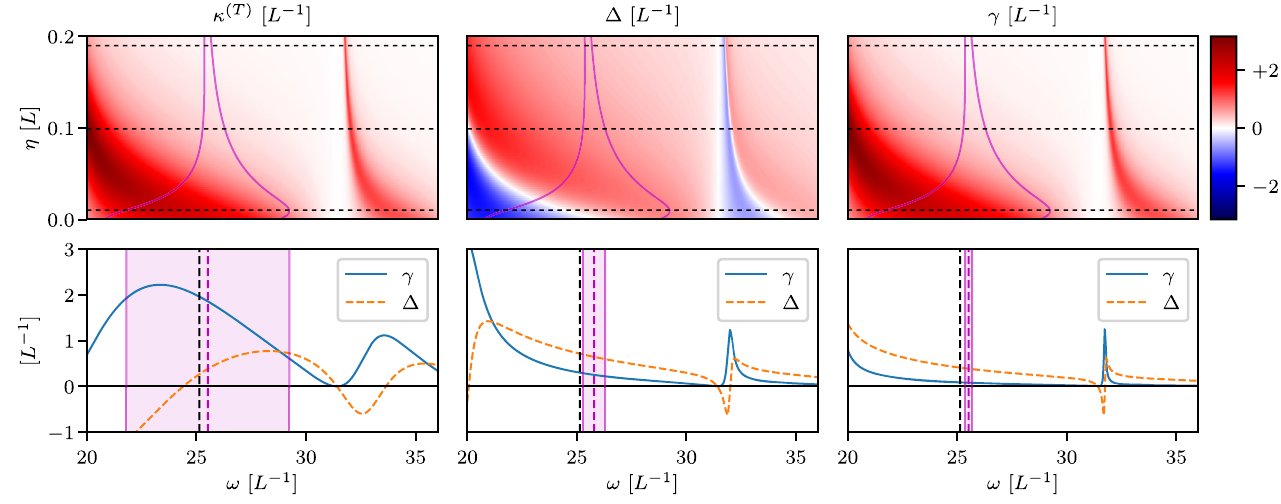
FIG. 6. Quantum optical parameters calculated via the ab initio few-mode theory. The upper row shows the transmission coupling strength κ ð T Þ ¼ 2 π j W j 2 , the mode frequency shift Δ , and the resonance width γ as a function of the frequency and mirror quality η . The parameters are as in the upper row in Fig. 5, with the system comprising the single mode λ ¼ 8 . The magenta curves indicate the width of the resonance as a function of η . The lower row shows cuts through the upper panels at fixed η ¼ 0 . 01 , 0.1, 0.19 (left to right, corresponding to the transition from a bad to a good cavity) indicated as dotted lines in the upper panel. The respective widths of the modes are indicated as shaded magenta regions, defined as twice the value of γ . The vertical dashed lines indicate the bare center frequency of the mode (black) as well as the actual center frequency